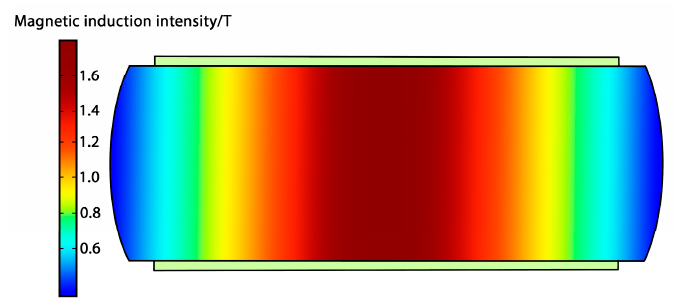
Figure 3. Magnetic field distribution in x-z plane of iron-cobalt alloy prism. Adjusting the solution domain in the Ansys magnetic field module and setting the incoming DC current of the coil to 0–10 A can make the prismatic iron-cobalt alloy produce a magnetic field strength of 0–134.78 kA/m. Adjusting the solution domain in the Ansys solid mechanics module, setting the point load conditions, and applying a force of 0–120 kn at in the prismatic section. The simulation results show the simulation relationship between magnetic induction intensity and compressive stress under different bi-as magnetic fields, as shown in Figure 4. When the bias magnetic field intensity is less than 3.11 kA/m, the change rate of magnetic induction intensity with compressive stress is small, because the stress has little effect on domain deflection under a weak magnetic field. When the bias magnetic field intensity is in the range of 3.11–84.56 kA/m, the change rate of magnetic induction intensity is large, and the magnetic induction intensity decreases gradually with the increase of compressive stress. When the bias magnetic field intensity is greater than 84.56 kA/m, the change rate of magnetic induction intensity with compressive stress is small, mainly because the influence of stress on domain deflection becomes smaller due to the excessive magnetic field